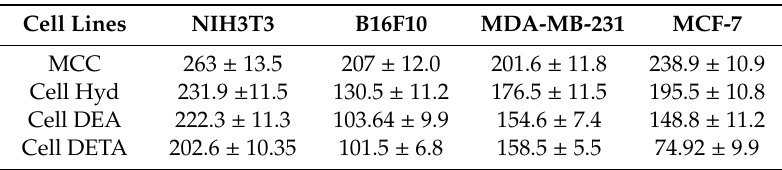
Table 3. IC 50 values for di ff erent cell